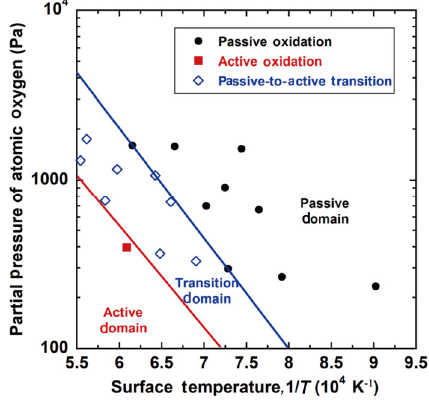
Fig. 7 Transition of active and passive oxidations: effect of temperature and partial pressure of atomic